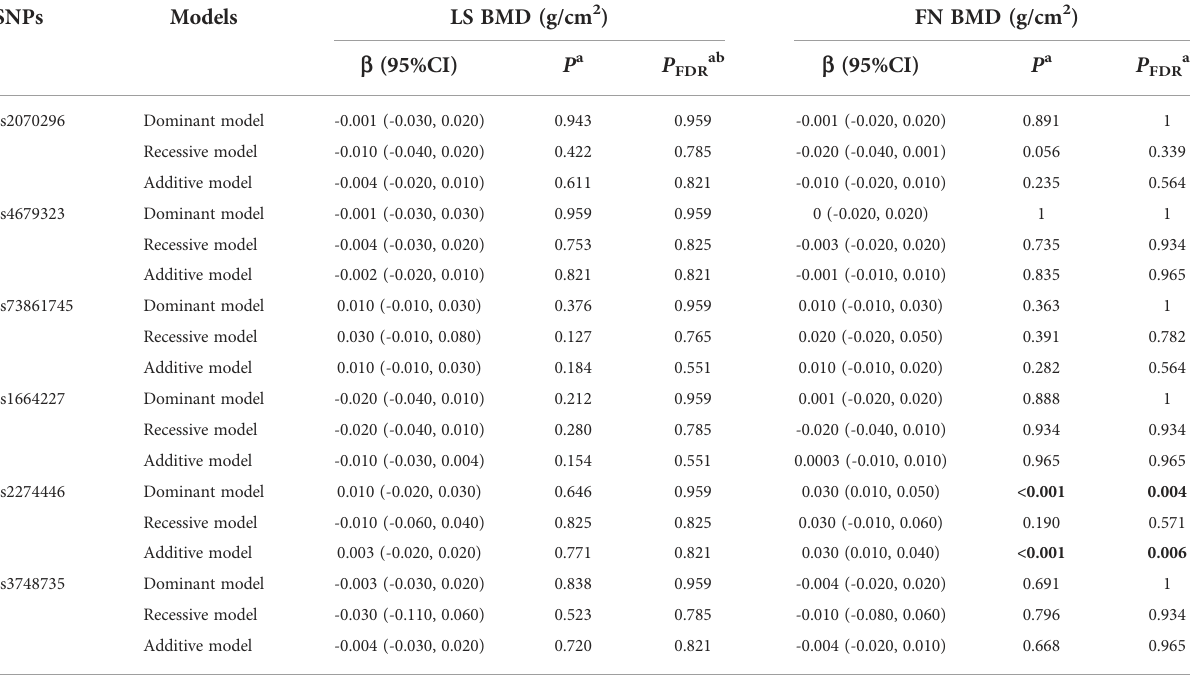
TABLE 3 Multivariate linear regression results of associations between common genetic variants and BMDs in the validation stage.